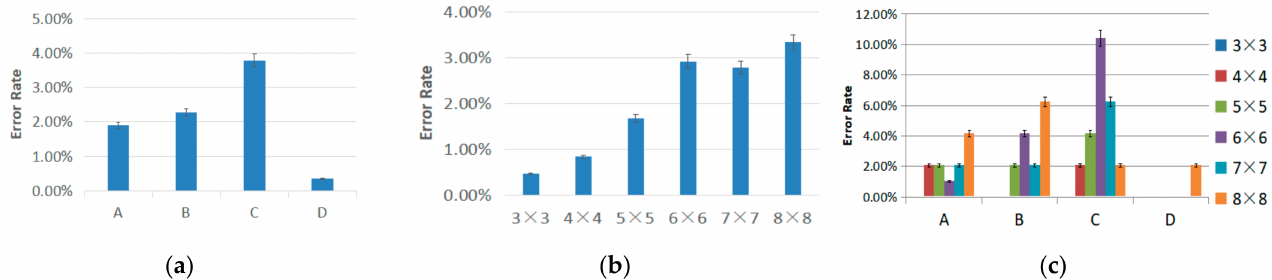
Figure 8. The error rate of comparative Experiment 1. The error bars represent a 95% confidence interval: ( a ) average error rate with different regions; ( b ) average error rate with different target size levels; and ( c ) average error rate for different target size levels under different regions (A, B, C, and